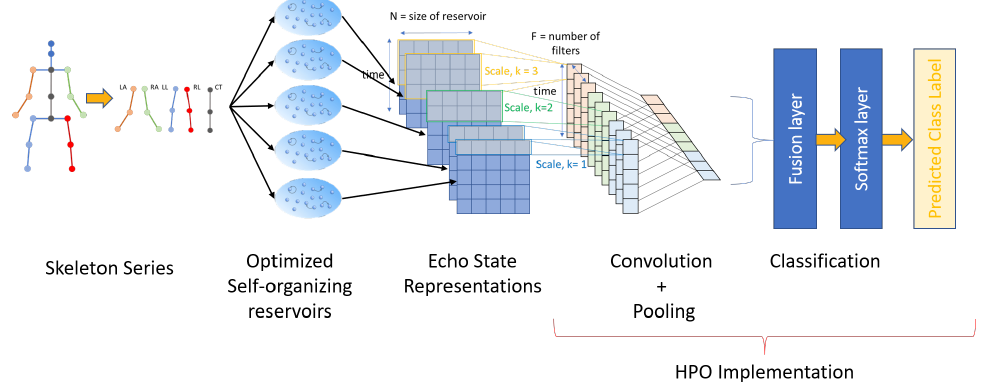
Figure 4. Overview architecture of SO-ConvESN. Optimized self-organizing reservoirs are generated by SORN-E and cascaded in multi-scale CNN with three time-scales, three filters and five channels for human action recognition. HPO implementation is solely conducted for the CNN stage.